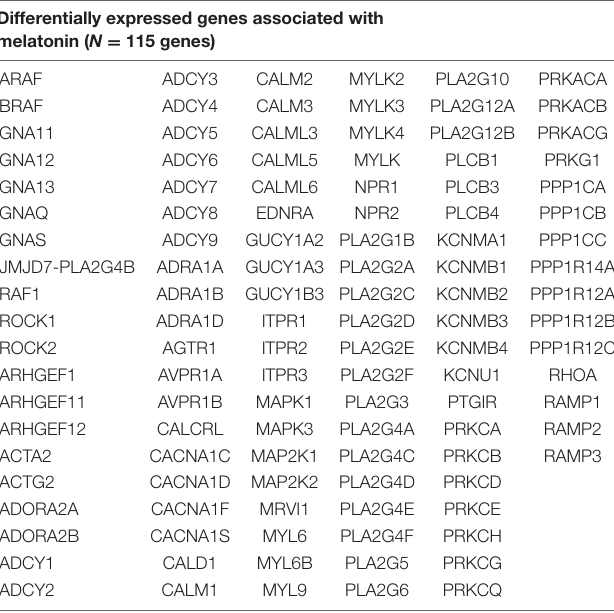
TABLE 3 | Vascular smooth muscle contraction pathways modified by melatonin supplementation.